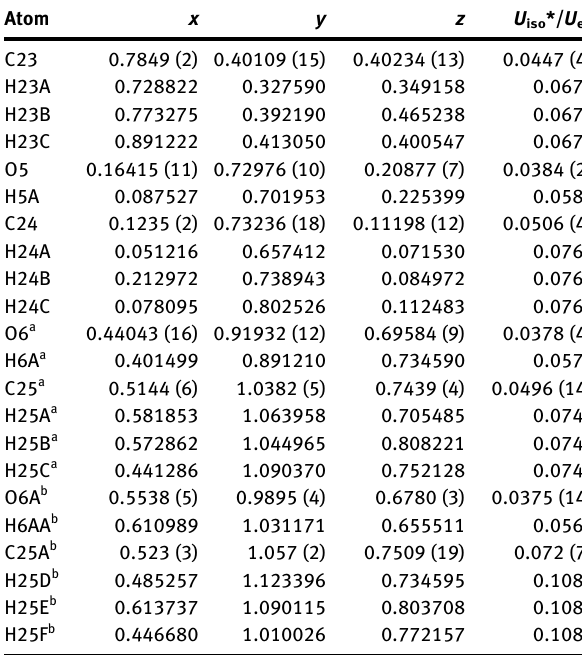
Table  : Fractional atomic coordinates and isotropic or equivalent isotropic displacement parameters (Å 